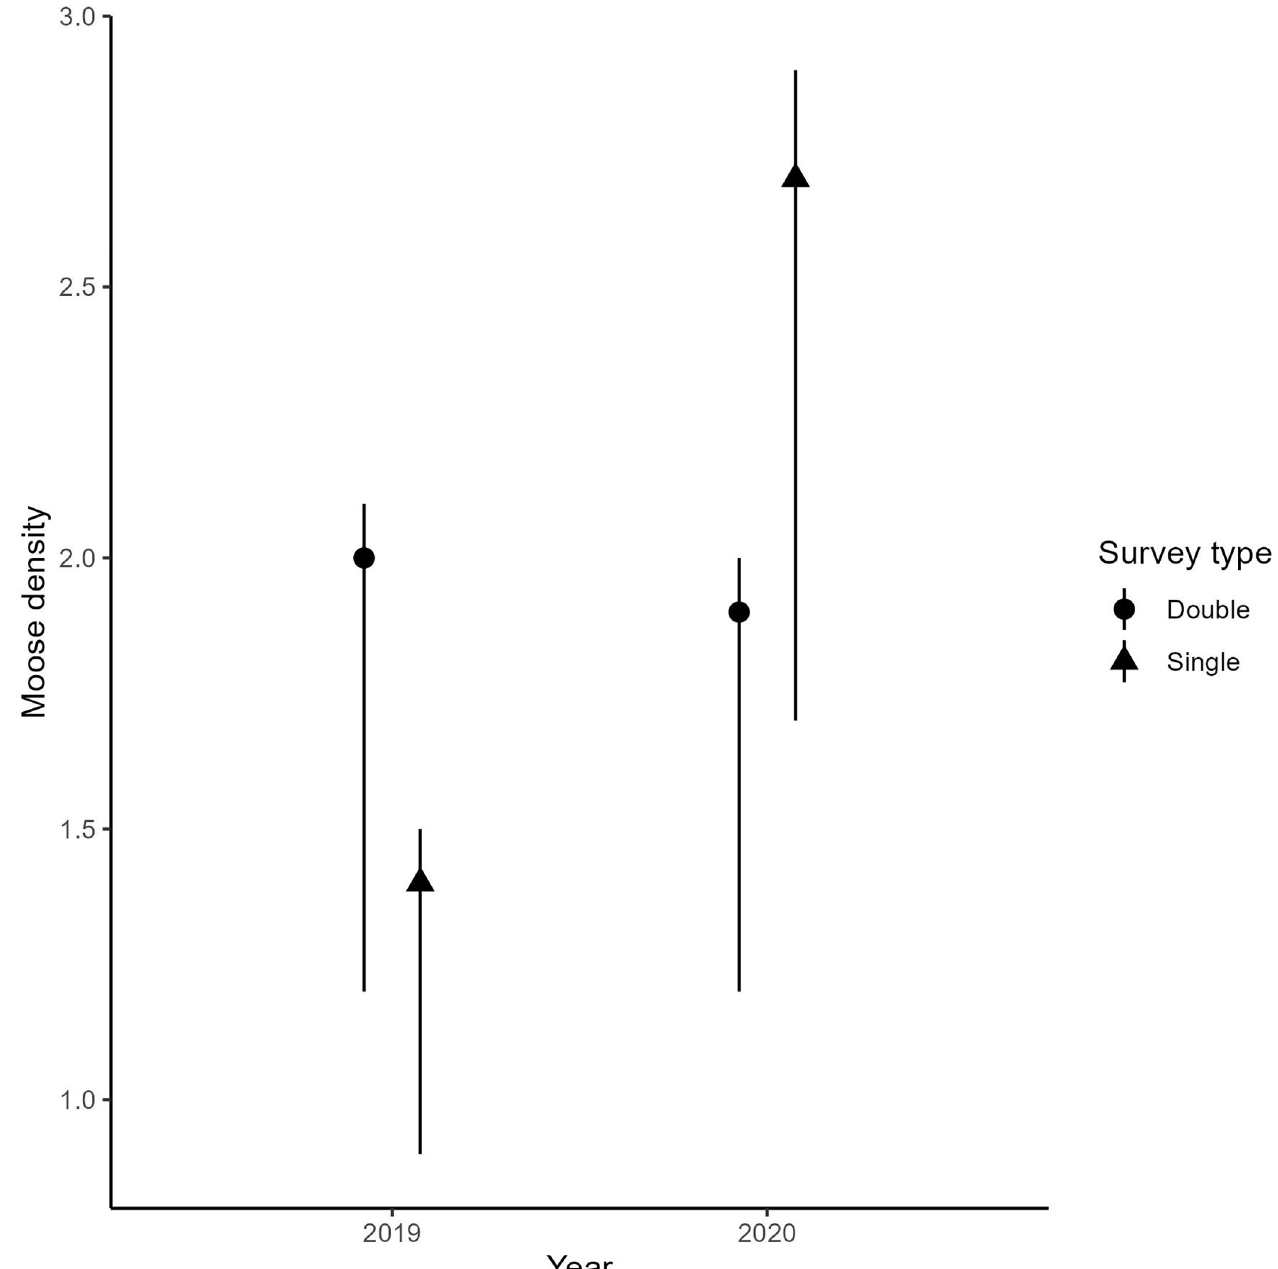
Fig 6. The number of moose per km 2 (i.e., moose density) by year and survey type (either double or single observer surveys).